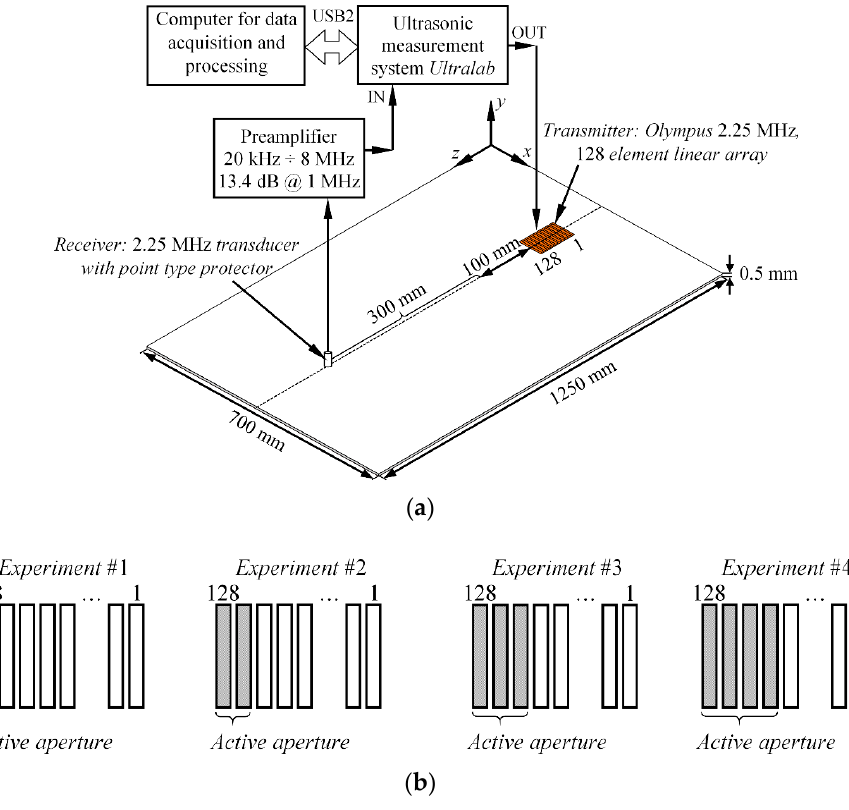
Figure 13. The experimental set-up for investigation of source size influence on guided wave mode spectrum ( a ) and the array aperture configurations used throughout experiments ( b ).